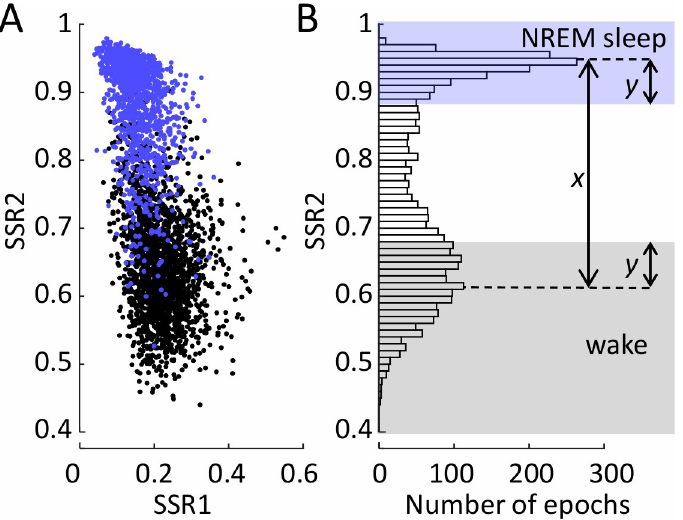
Fig 1. Method for automated classification of vigilance state using state space ratios. (A) State space ratios (SSRs) of each wake (black symbols) and non-rapid eye movement (NREM) sleep (blue symbols) epoch during a single night, for an example (normal) sheep. The two frequency ratios used are SSR1 (6.5–9/0.5–9 Hz) and SSR2 (0.5–20/0.5–100 Hz). (B) Histogram of all epochs during the recording night according to their SSR2 value, for the same sheep. The histogram is overlaid with an indicative diagram of the automated scoring method. The value x is the distance between the two highest peaks of the histogram, and length y is 20% of x . All epochs with SSR2 values between 1 and the value at the upper peak minus y , are classified as NREM sleep (highlighted by blue shading). All epochs with SSR2 values below the value at the lower peak plus y , are classified as wake (highlighted by grey shading). As the distribution of SSR2 values differs between sheep and channel, so do the x and y values and peak locations that define the NREM sleep and wake boundaries. This method ensures that these boundaries are relative to each sheep/channel, and importantly, that they cannot